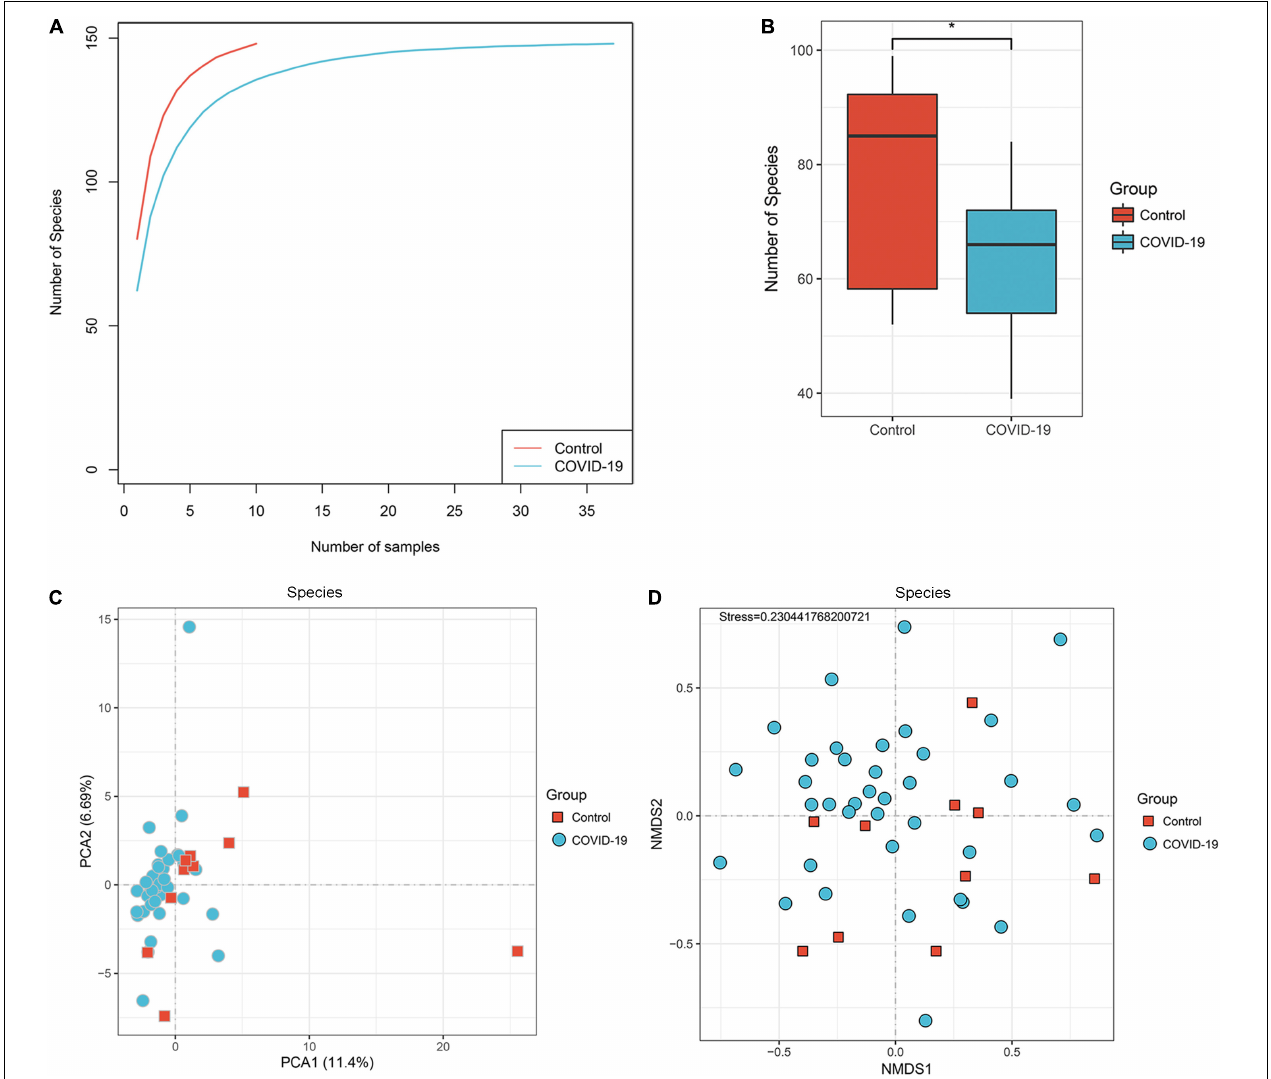
FIGURE 1 | Differences in gut microbial diversity between COVID-19 and healthy controls (HC). (A) The rarefaction analysis between the number of samples and the number of species. As the number of samples increased, the number of species approached saturation in COVID-19 ( n = 37) and HC ( n = 10). (B) Compared with the HC, the number of species in COVID-19 was decreased significantly. * p < 0.05. (C,D) The principal component analysis (PCA) based on Bray–Curtis distance and the non-metric multidimensional scaling (NMDS) based on species level distribution showed that the gut taxonomic composition differed markedly between individuals in both COVID-19 patients and healthy controls (all p < 0.05;